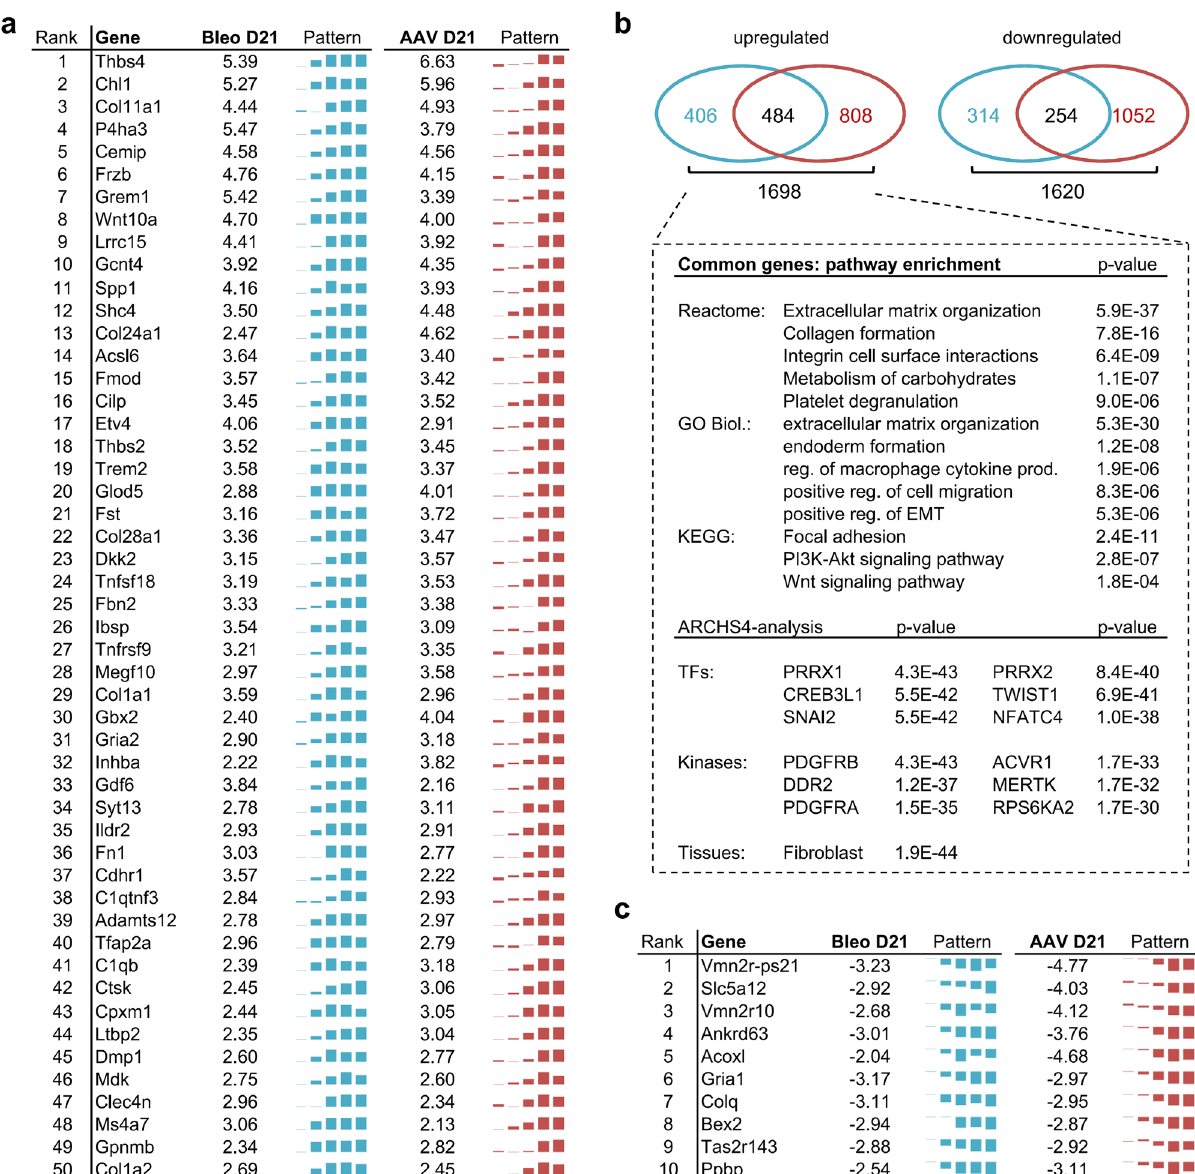
Figure 4. Genes associated with lung function decline. mRNAs of importance to fibrosis were identified by correlating their longitudinal gene expression changes to the decline in lung function observed in the respective model. ( a ) The top 50 highest expressed mRNAs showing strong anti-correlation to lung compliance (Pearson r ≤ − 0.85) and significant alteration (adj. p -value ≤ 0.05 at day 21 in both models) with consistent direction of expression (mean log 2 FC ≥ 0 in both models) are shown. log 2 fold changes on day 21 are depicted together with the gene expression profile over all five time points. A list of all lung function (anti-) correlated transcripts, including correlation coefficients is supplied as Suppl. Table 2. ( b ) Venn diagrams of mRNAs showing strong lung function (anti-)correlation (threshold defined as |Pearson r|≥ 0.85) in either only one (blue = Bleomycin, red = AAV-TGFβ1) or both models. EnrichR analysis of Reactome, KEGG and GO biological pathways as well as ARCHS4 transcription factor co-expression, kinase co-expression and tissue predictions for all commonly lung- function anti-correlated genes. ( c ) Top 10 lung function-correlated (i.e. downregulated) mRNAs identified using the criteria from ( a ), adapted for positive